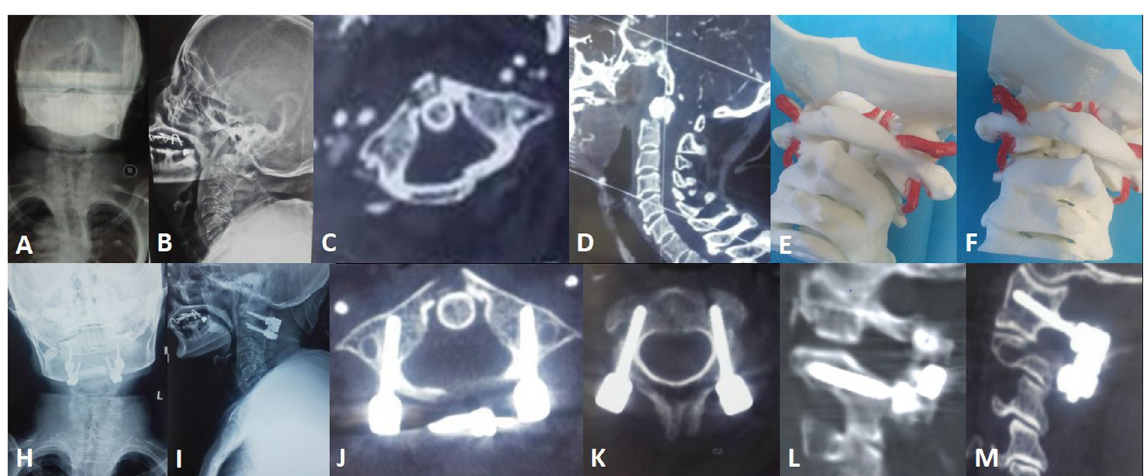
Figure 5. A 55 year-old female with atlantoaxial dislocation underwent posterior reduction and C1 pedicle-C2 pedicle internal fixation assisted by a 3D-printed life-size model. ( A – D ) Preoperative X-ray photographs showing a Jefferson fracture and odontoid fracture. ( E ) 3D life-size model showing that the vertebral artery on the left side was closer to the middle line and revealing the best screw trajectory. ( I – M ) Postoperative photographs showing that the screw position was